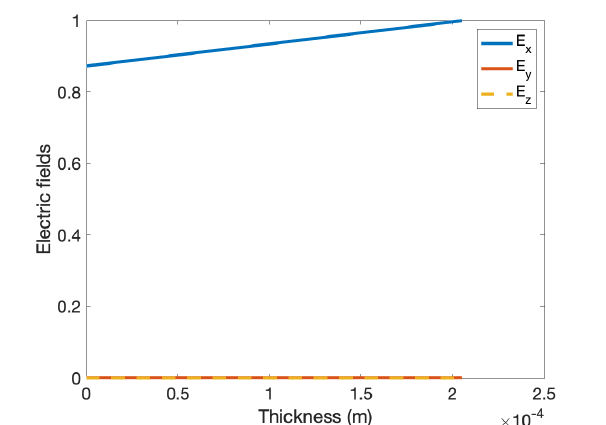
Figure 3. Simulated electric field when the incident field is polarized in the normal direction with respect to the fibers for ω 2 = 24.5 GHz.